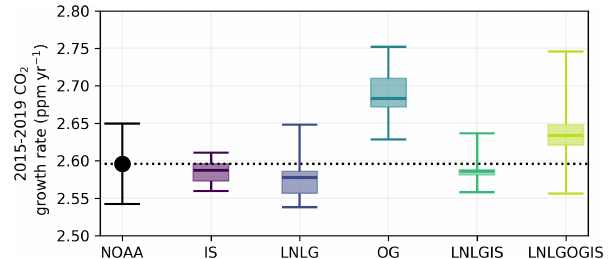
Figure 4. 2015–2019 global mean CO 2 growth rate estimated from NOAA site measurements and for the v10 OCO-2 MIP experiments. The estimates of the CO 2 growth rate for each experiment are com- puted by sampling the model CO 2 fields at the same times and lo- cations as those used to derive the NOAA measurement-based es- timate. Each v10 OCO-2 MIP experiment is shown as a box plot, with the error bars showing the full range, the shaded region show- ing the interquartile range and the solid line showing the median ensemble member of the ensemble.